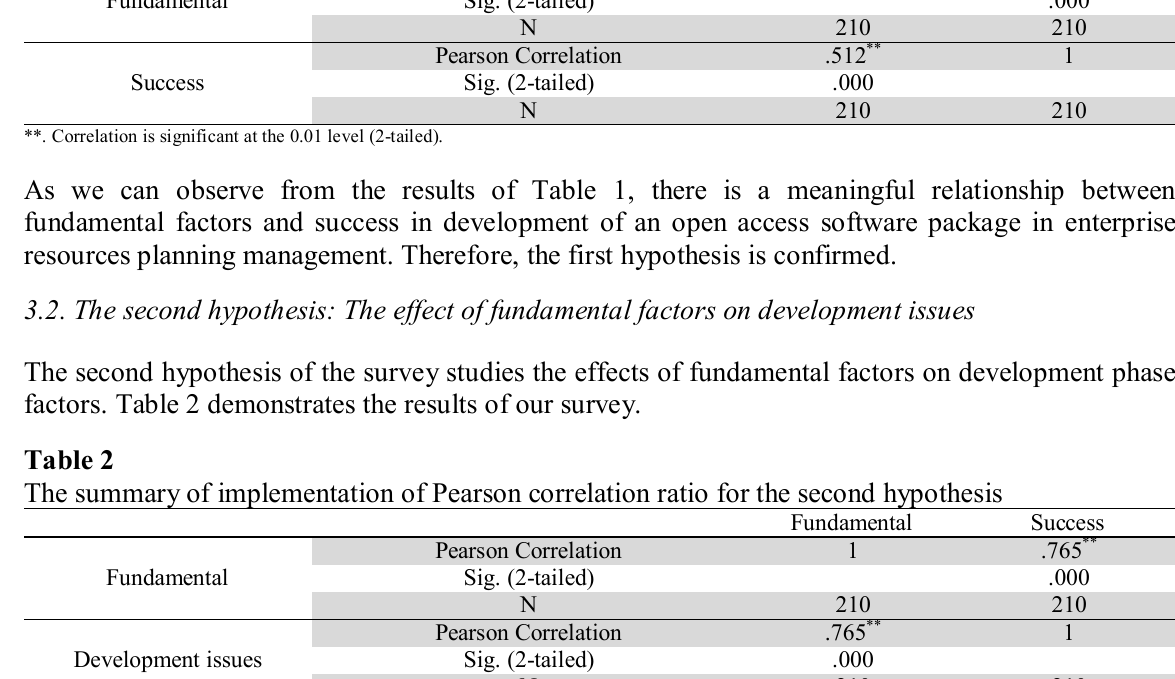
The summary of implementation of Pearson correlation ratio Fundamental